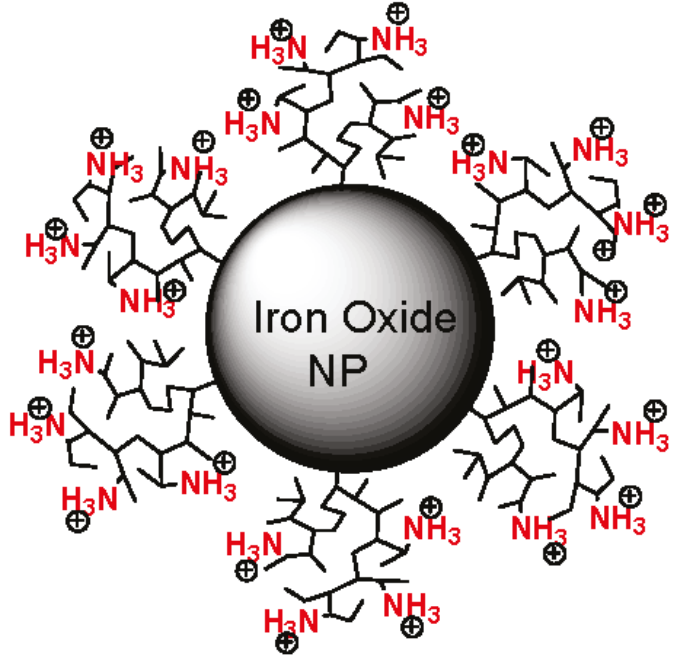
Figure 2. An example of magnetopolyplexes. Magnetic iron oxide nanoparticle coated with polyethylenimine. Adapted with permission from [112]. Copyright American Chemical Society, 2011.